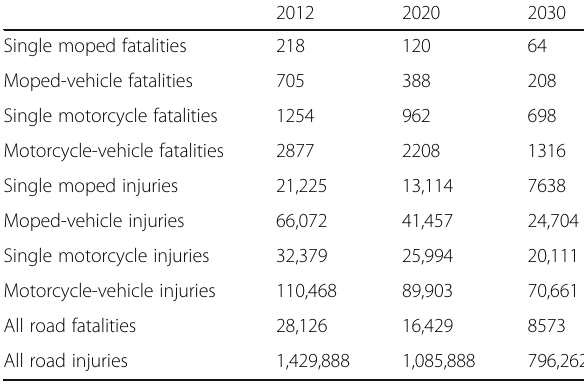
Table 1 Total number of moped, motorcycle and all road fatalities and injuries in the EU-28 used in the calculations. The 2012 data are obtained from the CARE database (injuries) and the EU statistical pocketbook (fatalities). The accident numbers for 2020 and 2030 are estimations based on the identified accident trends, see [43] for more